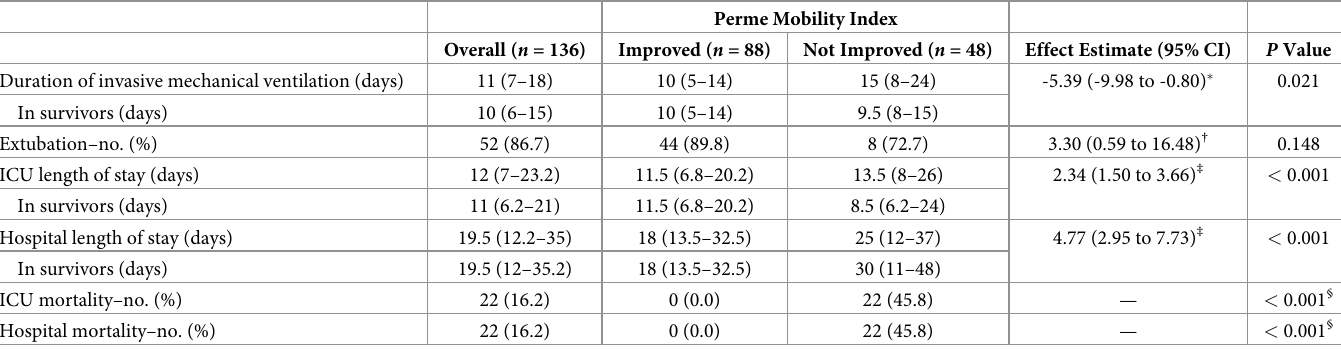
Table 2. Clinical outcomes of the included